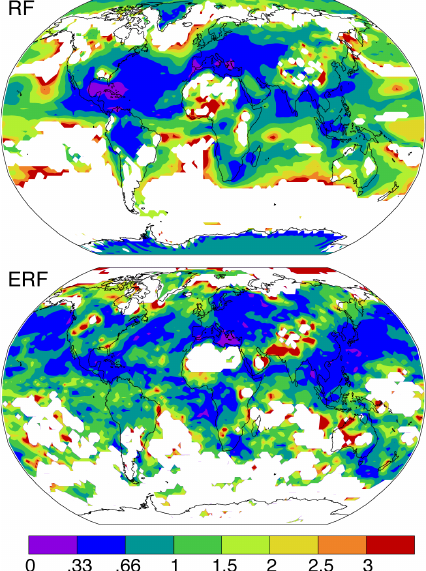
Fig. 17. The ratio of the standard deviation across models to the multi-model mean value for RF and ERF. Absolute values of the 1850 to 2000 forcings are used in these ratios. Areas with forcing less than 1/4 of the global mean are blank to avoid division by small values. Both analyses use the same 8